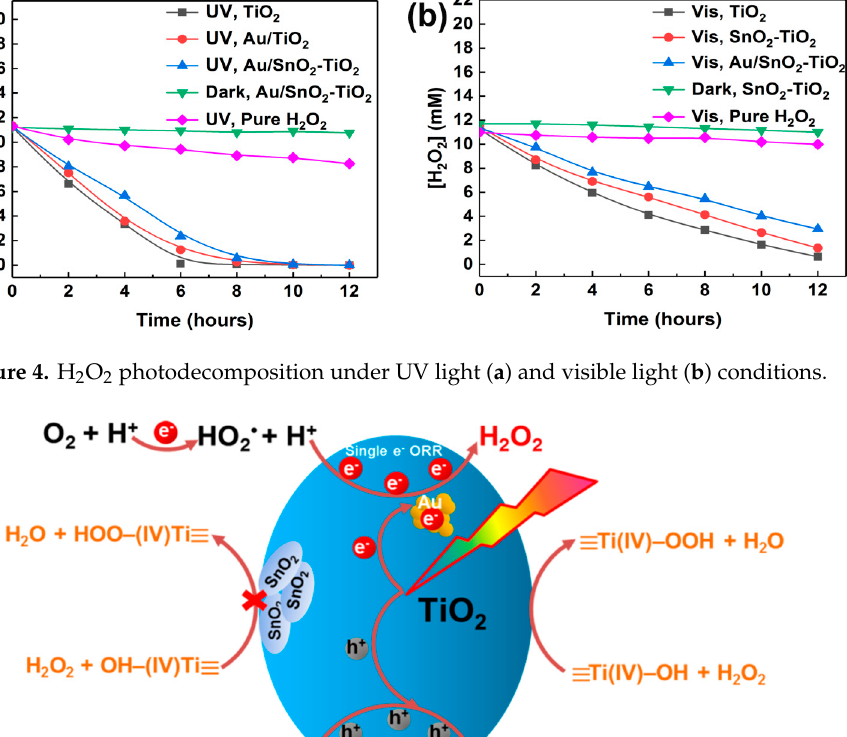
Figure 5. Schematic illustration of H 2 O 2 synthesis and decomposition over Au/SnO 2 -TiO 2 .